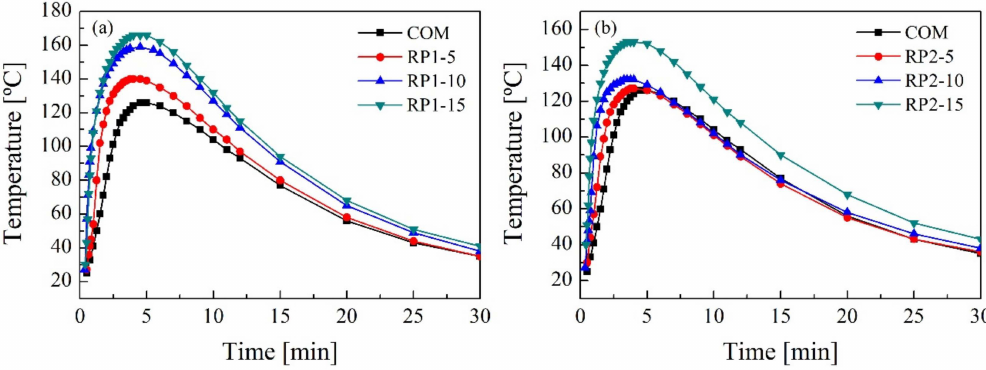
Figure 6. Temperature profiles in reactions with ( a ) RP1 and ( b ) RP2.